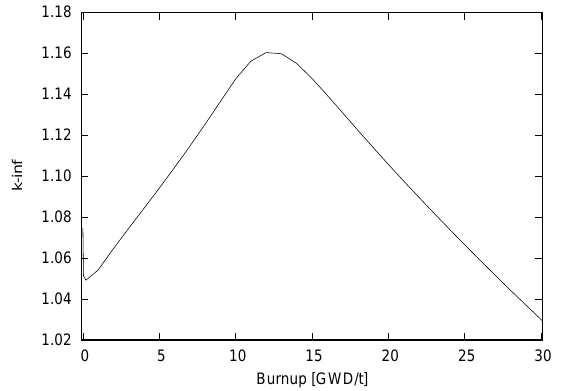
Fig. 3 . The Pu-239 build up and the burnout of Gd-155 and -157 can be found. The fuel burnup values corresponding to the burnout of Gd-155 and -157 are approximately 18 and 12 GWD / t, respectively.